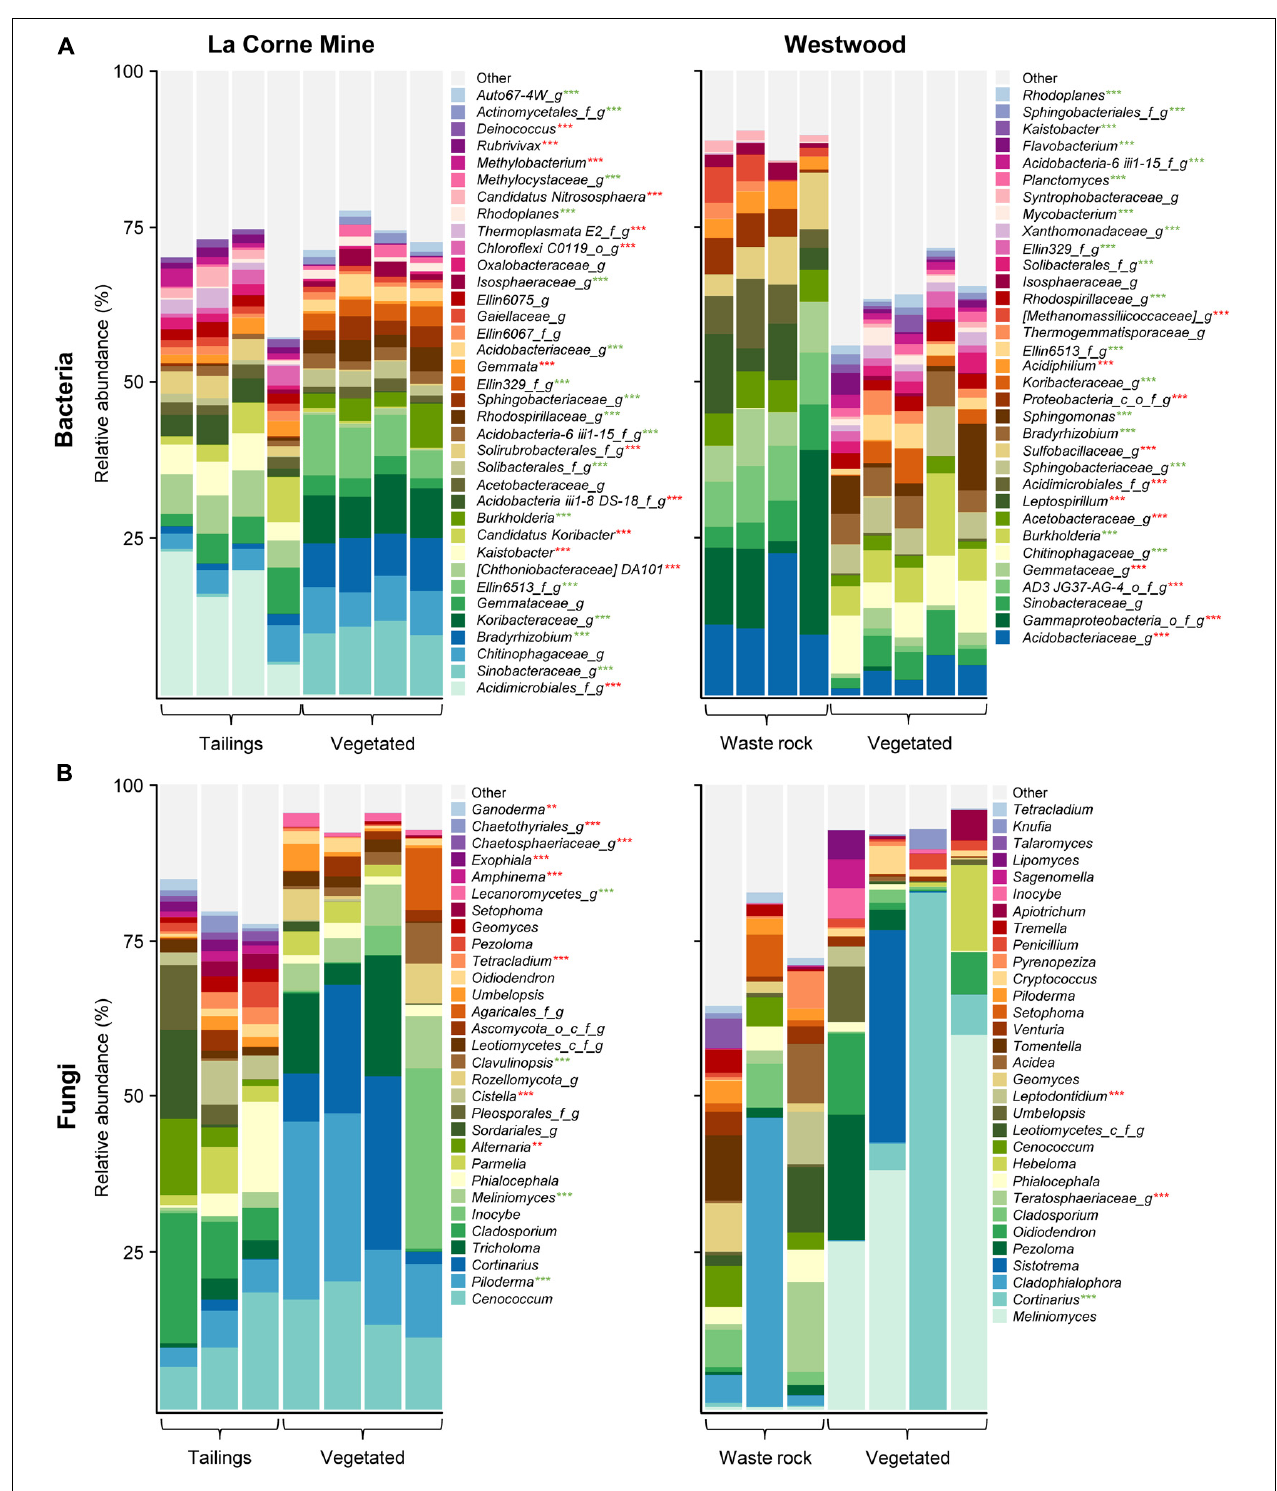
FIGURE 2 | Taxonomic profiles of bacterial and fungal communities in vegetated and unvegetated samples of waste rock from the Westwood site and tailings from the La Corne Mine site. Taxonomic profiles of bacterial communities (A) and fungal communities (B) at the genus level. Only bacterial and fungal taxa with a relative abundance > 1% in at least one treatment are shown. Green and red stars represent a significant increase and decrease, respectively, in the relative abundance of the taxa in the vegetated soil compared to the unvegetated soil as determined by a Tukey HSD post hoc pairwise comparison test ( n ≥ 3). Significance level is represented as follows: p < 0.05 *, p < 0.01 **, p < 0.001 ***. Pseudo-replications of each location were pooled to simplify visualization.